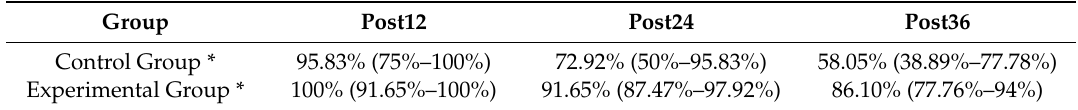
Table 3. Exercise